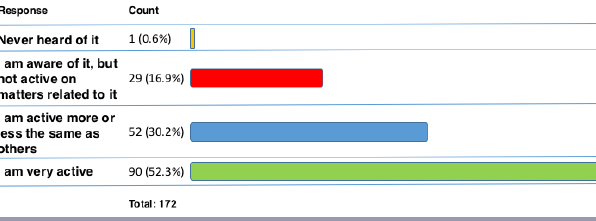
Fig. 8 . Participant responses to the question, “How active are you on matters related to